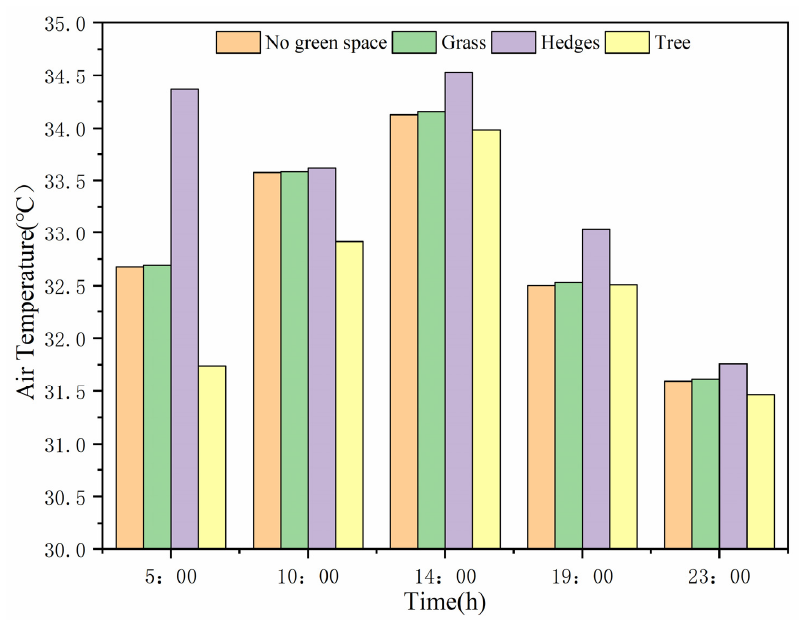
Figure 12. The air temperature of different waterfront vegetation types at different time points.